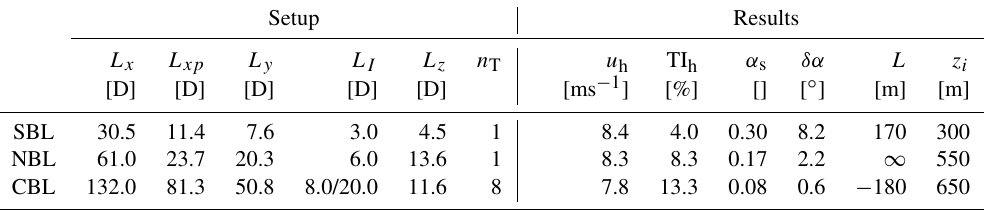
Table 1. Setup of the three simulations and results by the end of the prerun. Domain dimensions (see Fig. 2) are given in multiples of rotor diameter D. The number of turbines in the main simulation is n T . Results consist of wind speed u h and turbulence intensity TI h at hub height, wind shear coefficient α s and veer δα , both evaluated between lower and upper rotor tip, Monin-Obukhov-Length L , and boundary layer height z i